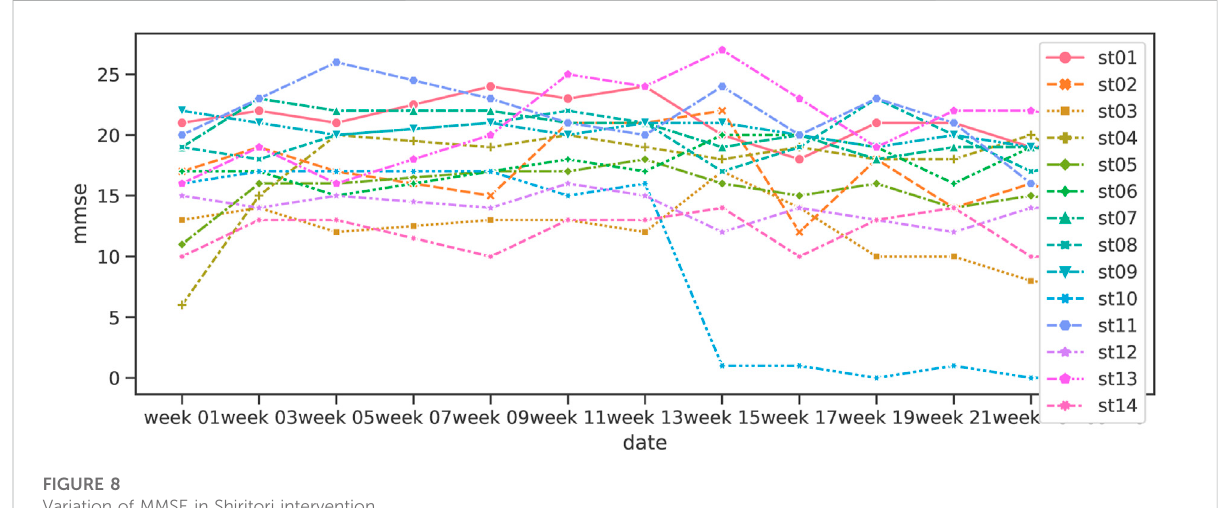
FIGURE 8 Variation of MMSE in Shiritori intervention.